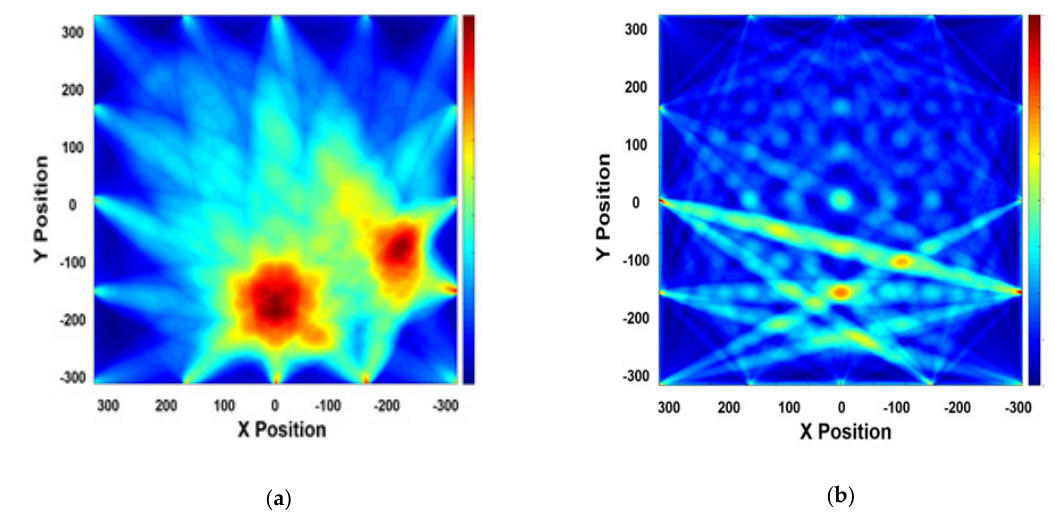
Figure 12. Comparison of RAPID tomographic images: ( a ) S0 3.0 MHz·mm and ( b ) A1 3.6 MHz·mm.